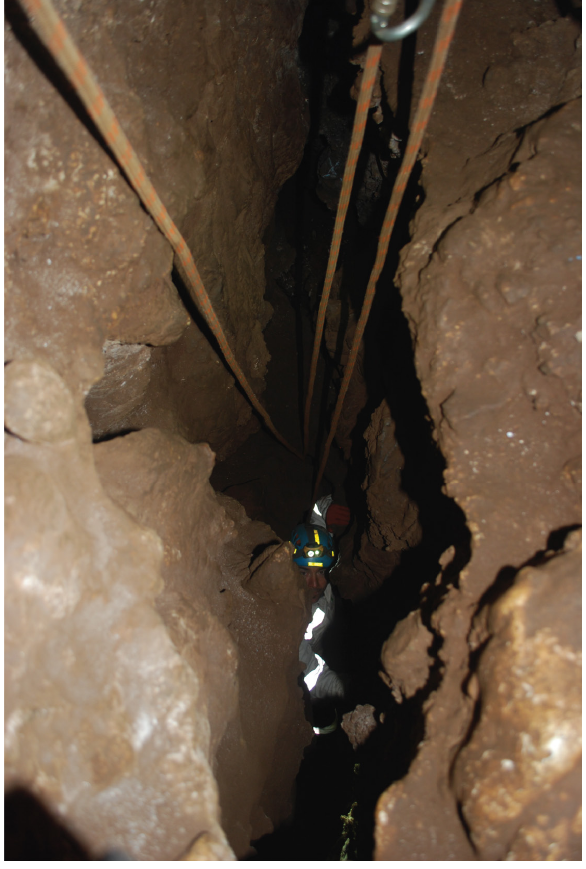
Photograph of the small confined nature of the ‘Chute’ within the Rising Star